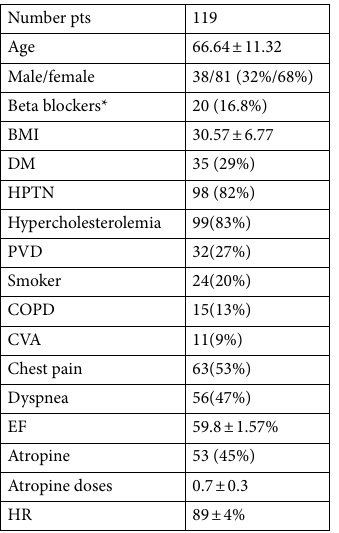
Table 1. Demographic characteristics. BMI body mass index, DM diabetes mellitus, HPTN hypertension, PVD peripheral vascular disease, COPD chronic obstructive pulmonary disease, CVA cerebral vascular accident, HR heart rate. *Beta blockers were stopped prior to